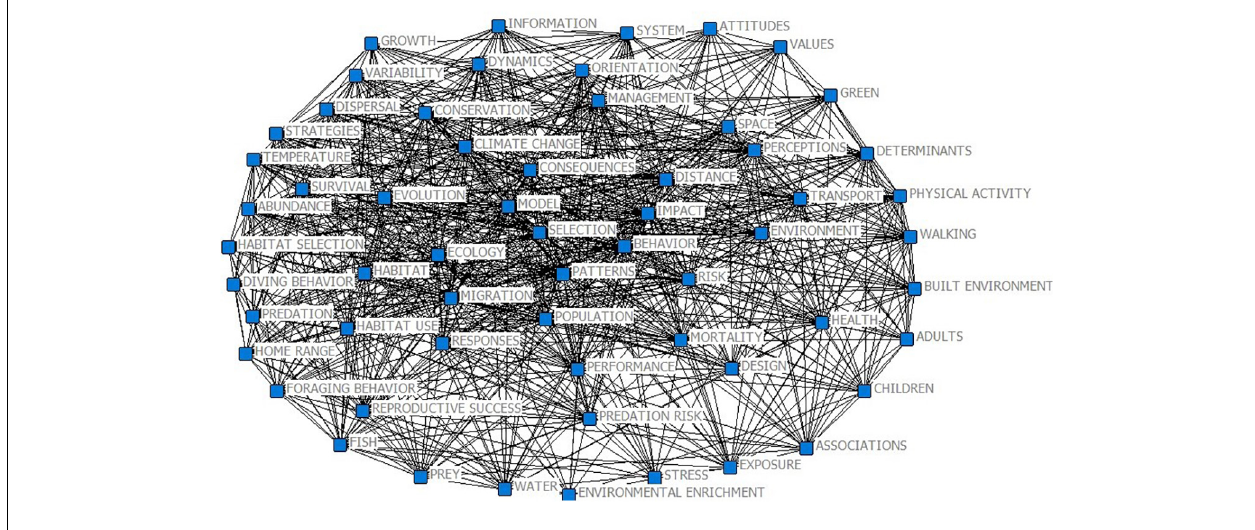
FIGURE 4 | Social network diagram of high-frequency keywords.